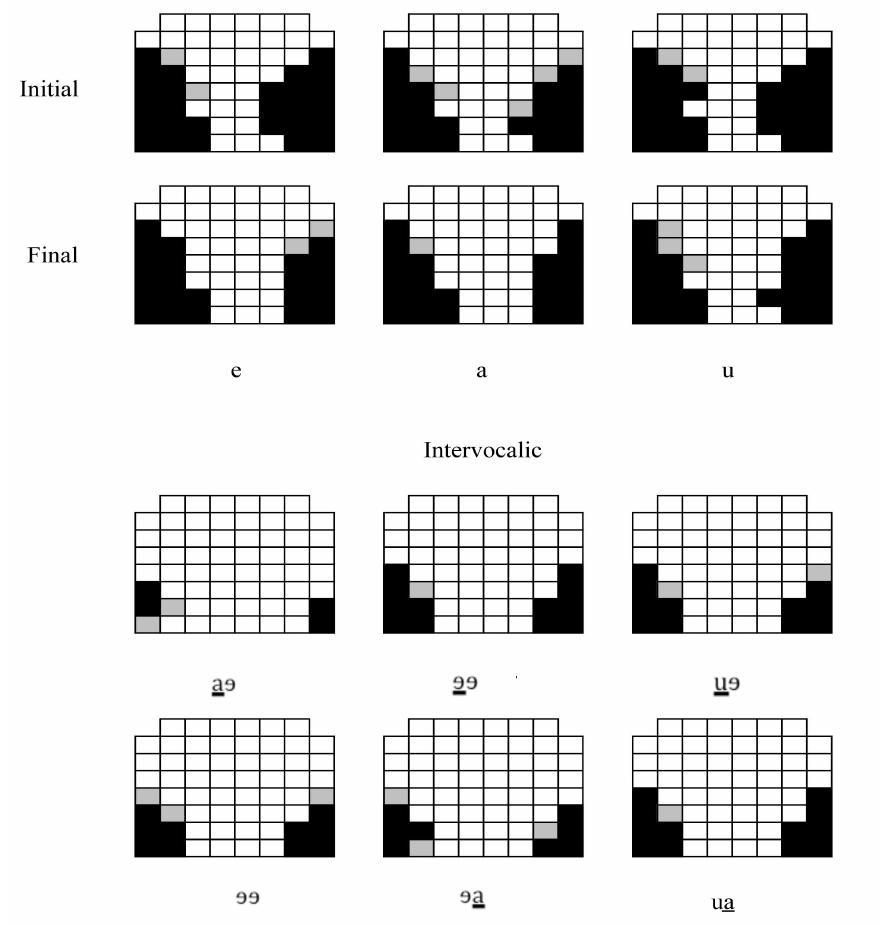
FIGURE 1. EPG contact configurations for [j] in initial position (top row), final position (second row) and intervocalic position (two bottom rows) for the Majorcan speaker BM. Contact patterns correspond to the vowel contexts [e, a, u] (initial, final), and [  a ɘ, ˈɘɘ, ˈ  ɘ, ɘɘ, ɘˈa, uˈa ] (intervocalic). Intervocalic stressed vowels appear underlined. See text for details about the graphic representation of the EPG contact